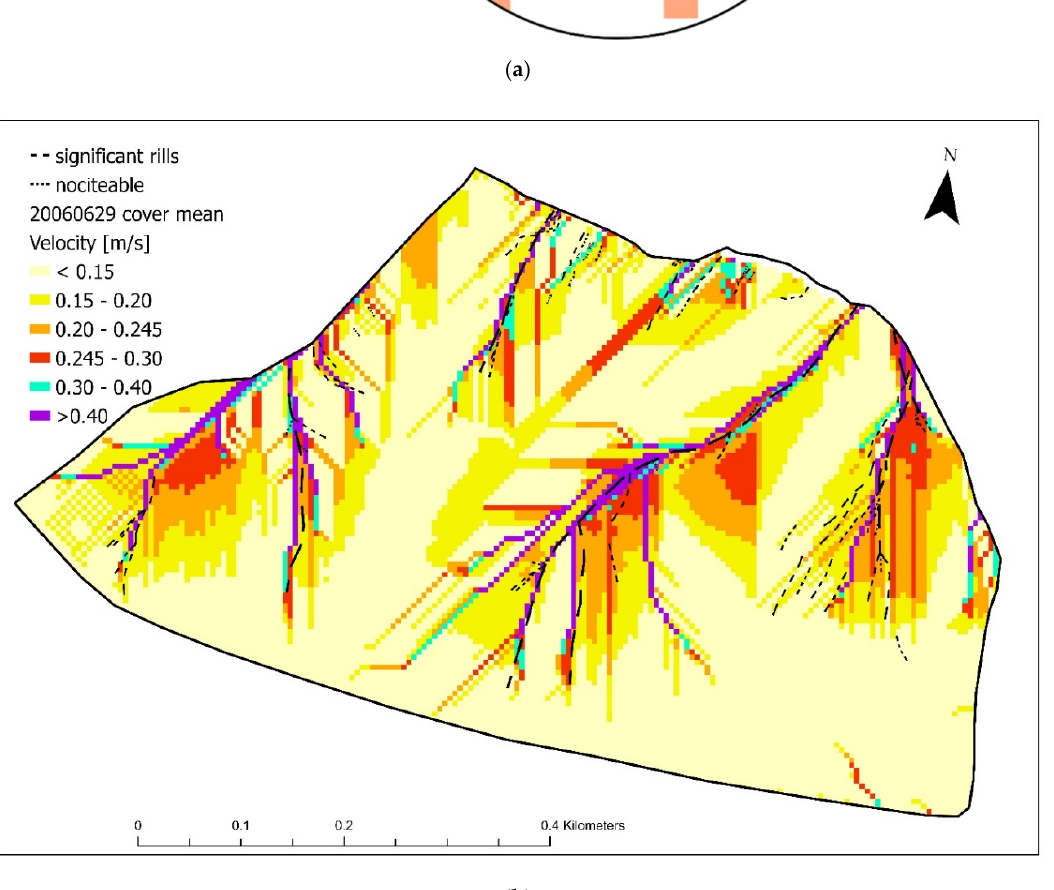
Figure 9. Differences between modelled rills and measured rills. ( a ) detail showing a different position of the rills (red colour—modelled significant rills, orange—modelled noticeable rills, green— significant measured rills, purple—notable rills, mixtures of these colours—brown and light orange are rills that are both modelled and measured). The lines are vectorized measured rills. The pixels are slightly shifted for better visualization, ( b ) sheet flow velocity for a calculation without the rill process. Cyan and magenta colours indicate speeds significantly exceeding the threshold.